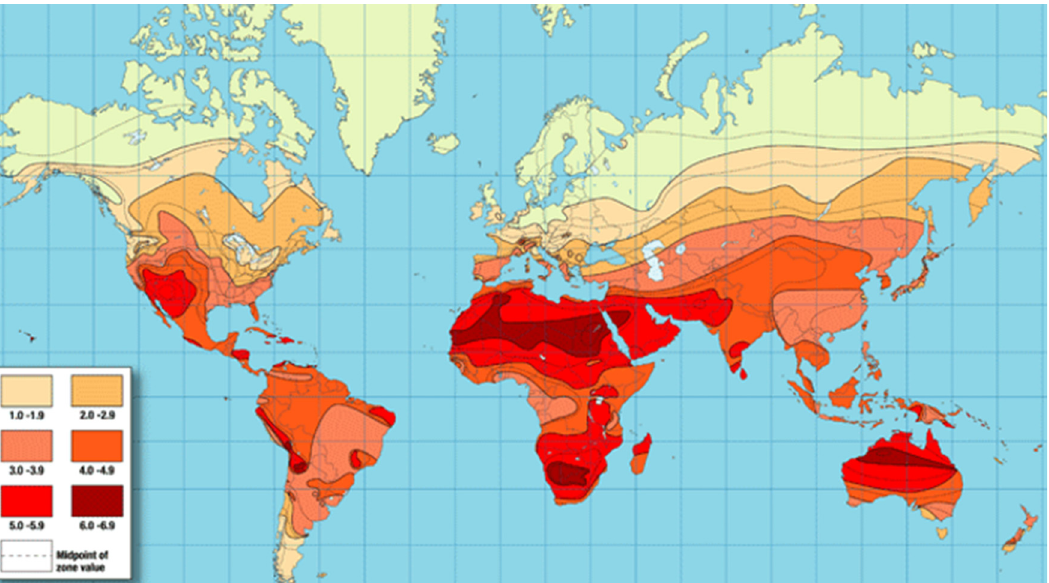
Fig. 12. Solar radiation globally- kWh/m 2 .